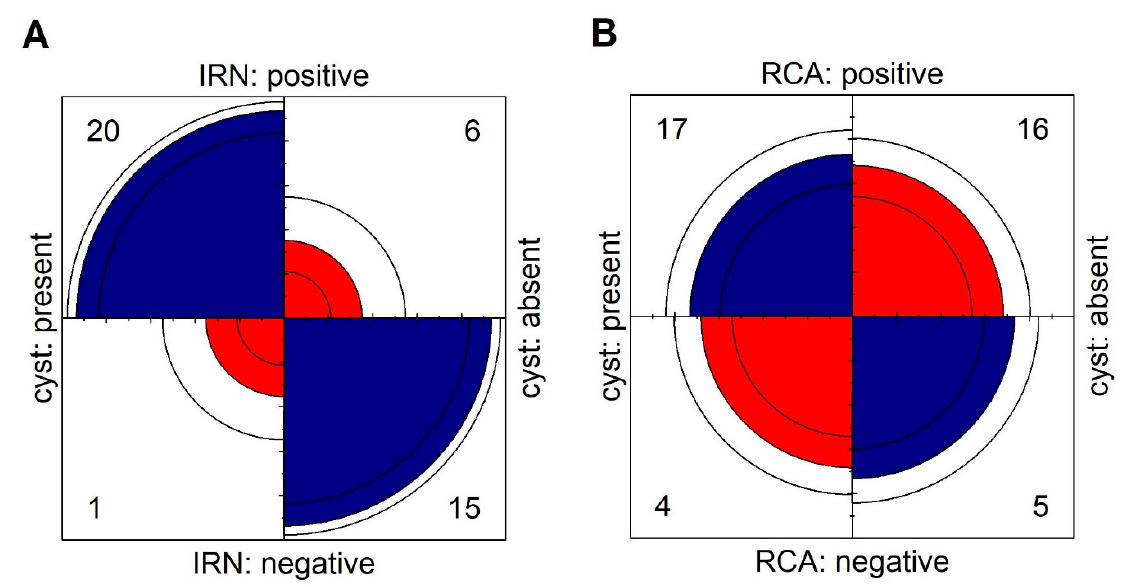
Figure 4. Fourfold display for presence of cysts and ( A ) IRN, ( B ) RCA. The area of each quadrant is proportional to the cell frequency. Circular arcs show the limits of a 95% confidence interval for the odds ratio in logarithmic scale.